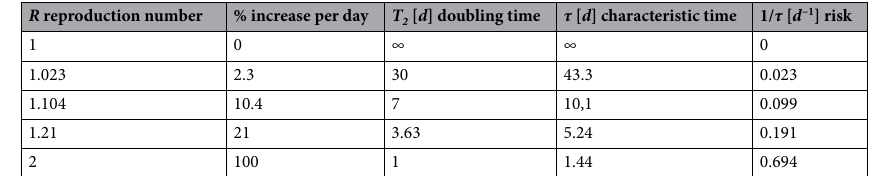
Table 1. Parameters describing the exponential growth phase.